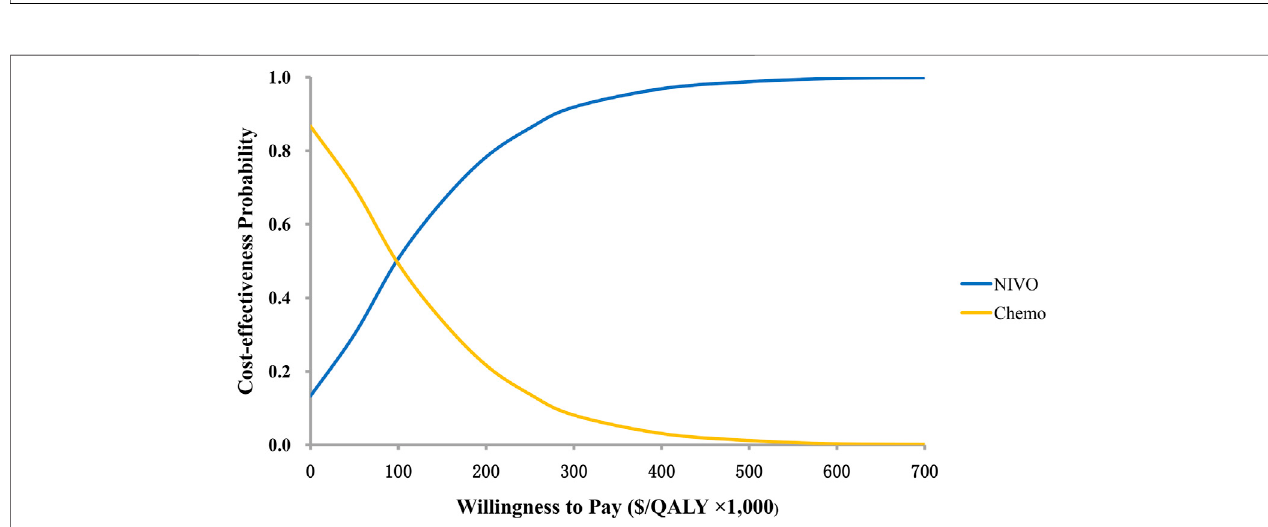
FIGURE 2 | The results of univariable sensitivity analysis. HR, hazard ratio; OS, overall survival; PFS, progression-free survival; NIVO, nivolumab plus ipilimumab; Chemo, chemotherapy; ICER, incremental cost-effectiveness ratio; QALY, quality-adjusted life-years.